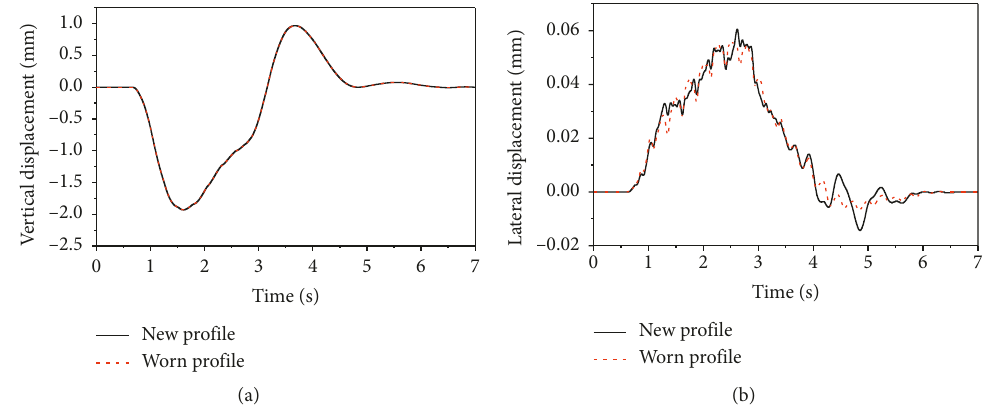
Figure 21: Time histories of displacement at the midsection of the left side span (speed: v � 350km/h): (a) vertical; (b) lateral.